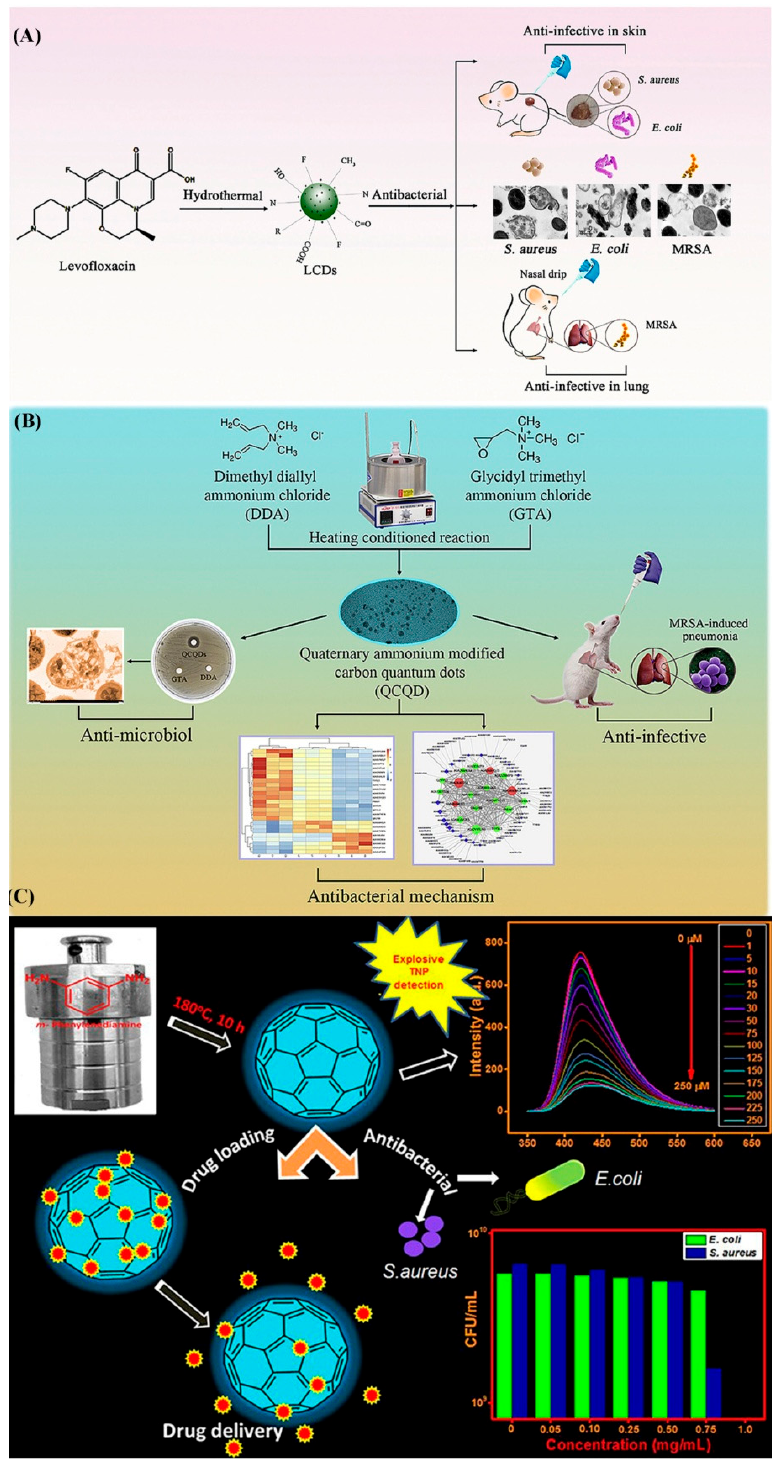
Figure 4. Antibacterial compound-derived CDs for killing microorganisms. ( A ) Construction and antibacterial characteristics of LCDs. Reproduced with permission from [74]. Copyright 2022 Elsevier Ltd. ( B ) Preparation of QCQDs from two quaternary ammonium compounds and their bactericidal properties and antibacterial mechanism. Reproduced with permission from [75]. Copyright 2020, Elsevier Ltd. ( C ) Scheme showing the preparation of N@CDs for delivering the traditional antibiotic ciprofloxacin to kill bacteria. Reproduced with permission from [57]. Copyright 2020, American Chemical